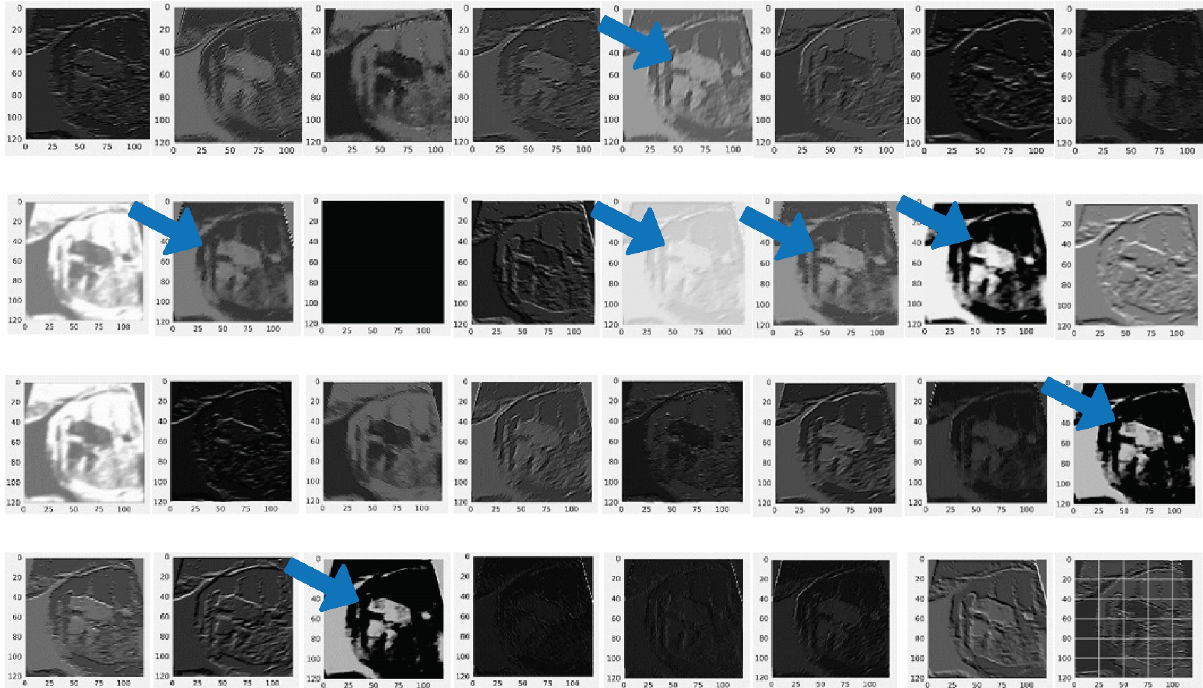
Figure 2. Proposed DenseNet201 architecture to classify seven CHDs and normal control.